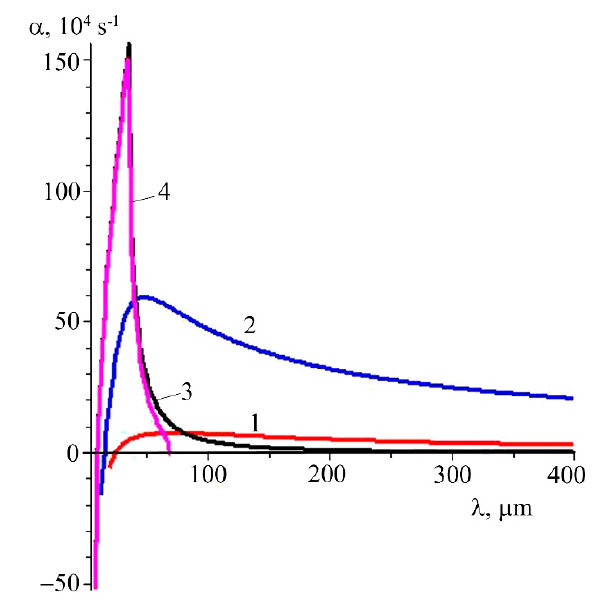
Figure 6. A growth rate characteristic of perturbations on the plasma–titanium melt interface for a gradient of surface concentration of 10 m − 2 /m found when solving the Equation (11): ( 1 ) ignoring thermoelectric and evaporation and capillary effects, ( 2 ) including the thermoelectric effect only, ( 3 ) with regard to thermal and evaporation and capillary instabilities, ( 4 ) involving thermal, evaporation and capillarity instabilities and the thermoelectric effect.